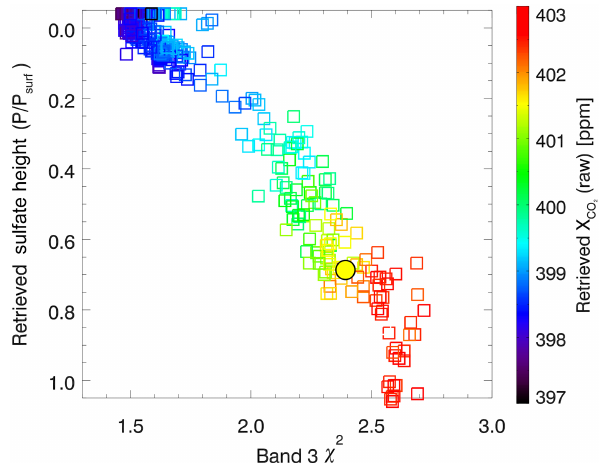
Figure 5. Results of several hundred retrievals of a single ocean glint sounding (28.5 ◦ S, 52.3 ◦ W) measured on 26 June 2015. Each retrieval is identical except that each has a different first guess state, consistent with the prior uncertainty distribution. The retrieved rela- tive sulfate height (0 = top-of-atmosphere; 1 = surface) is shown on the ordinate, the reduced χ 2 from the strong (2.06µm) CO 2 band re- trieval is shown on the abscissa, and the retrieved X CO is indicated 2 by color. For reference, the result from the operational retrieval (ver- sion 7) is shown as the large filled circle. When the retrieval places the sulfate near the surface, as in the version 7 case, both the strong CO 2 band χ 2 value and X CO tend to be higher. Conversely, when 2 the retrieval pushes the sulfate closer to the top-of-atmosphere, the strong CO 2 band χ 2 values and X CO tend toward lower values, a 2 result that is more physically